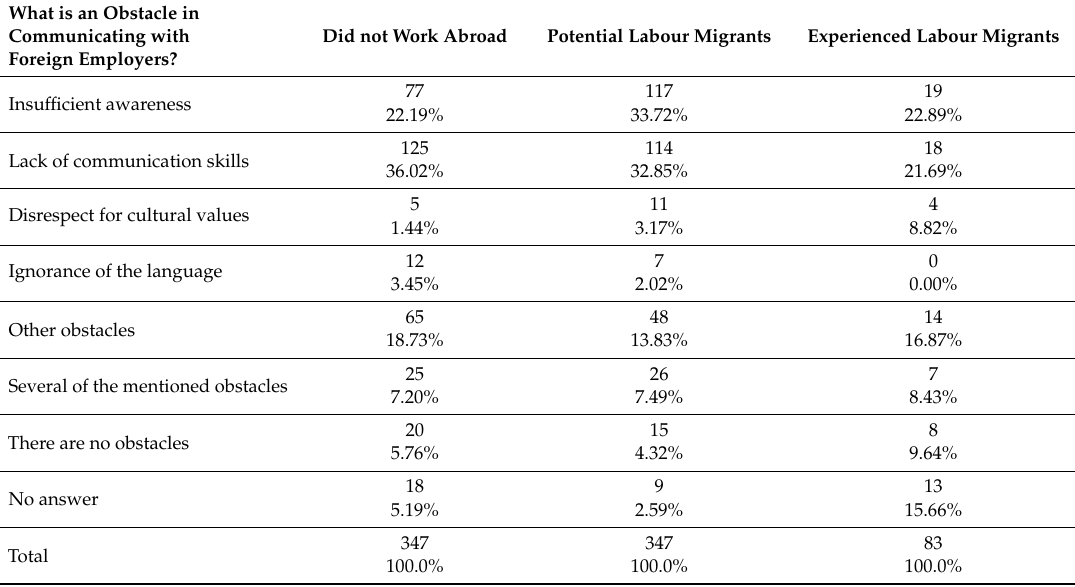
Table 3. The main obstacles in communication with foreign employers (N,